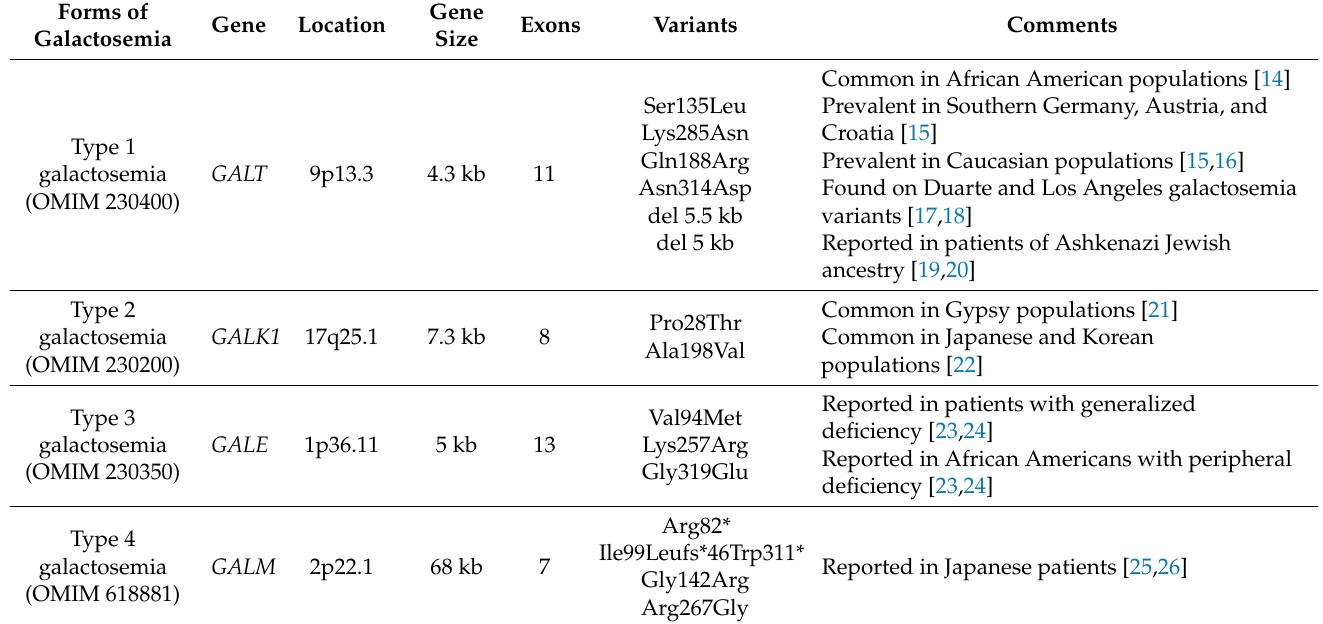
Table 1. Important molecular characteristics of